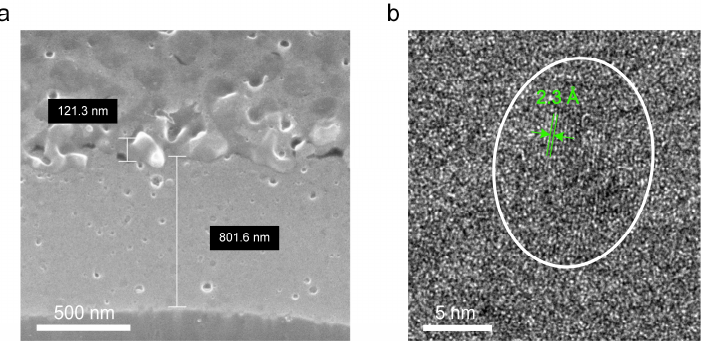
Figure 4. ( a ) FE-SEM image of the PLD-deposited AlN thin film covered with thermally evaporated Al as the electrode. ( b ) TEM image of the PLD-deposited AlN thin film.